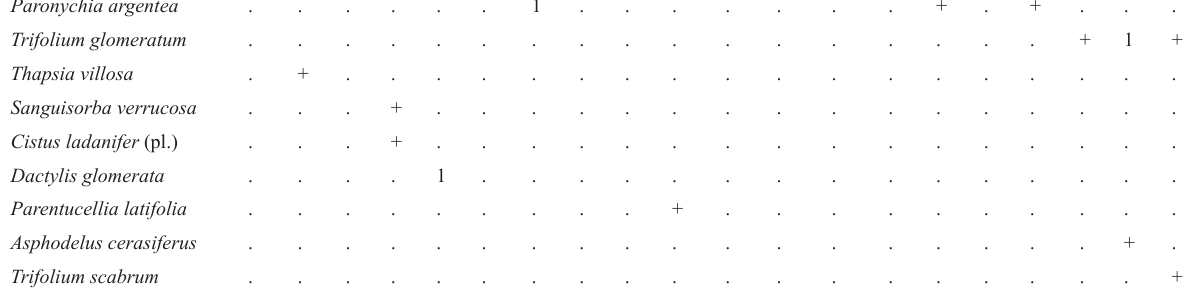
Table 6. Plots recorded in the “Atalaya” area (AB text for more explanations on plant communities and syntaxa. N.